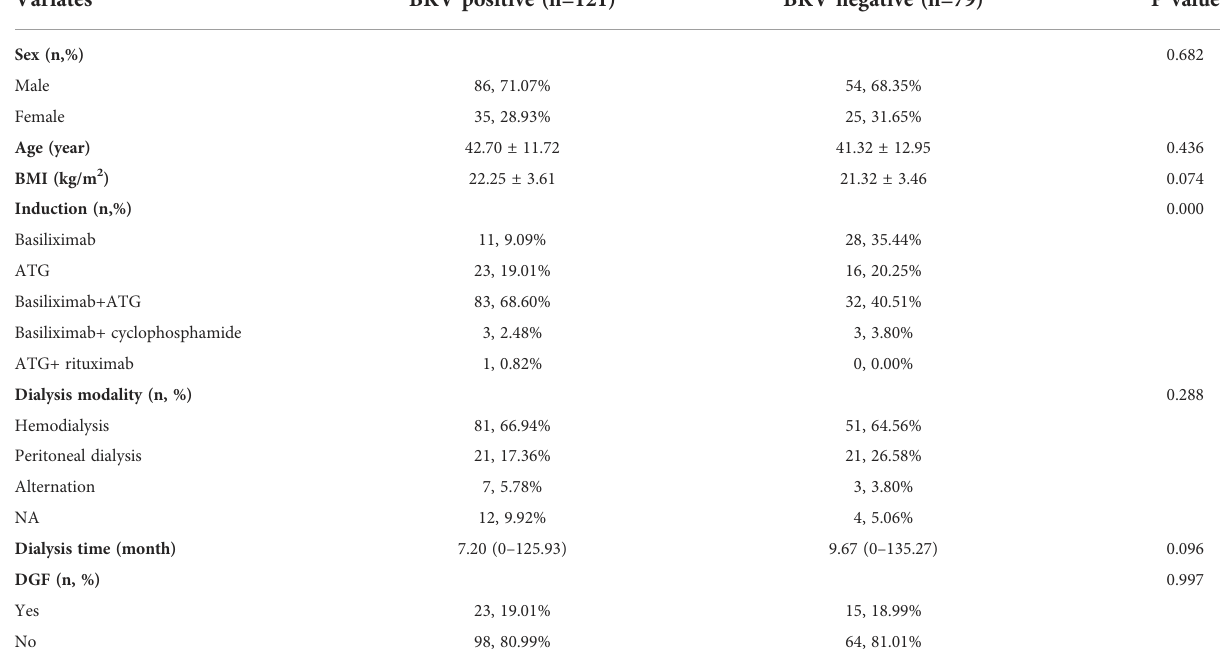
TABLE 1 The baseline clinical characteristics and demographic